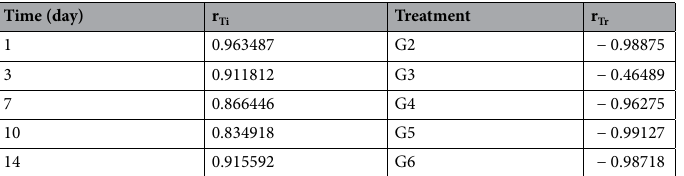
Table 2. Correlation coefficients between the tumor volume and treatment (r Tr ) and experimental time (r Ti ). G2, Tumor control group; G3, doxorubicin-treated group; G4–G6, groups treated with 100, 200 or 400 mg/kg of PSO nano-emulsion (G4, G5, G6) respectively.